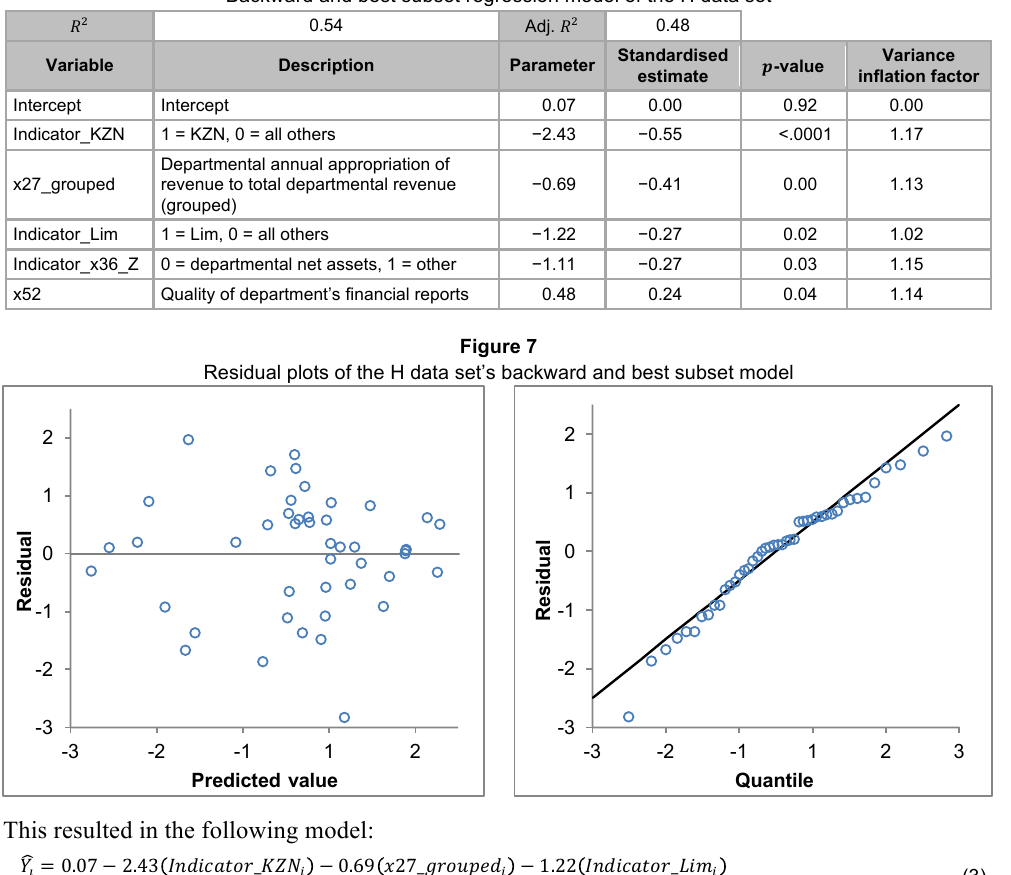
Backward and best subset regression model of the H data set